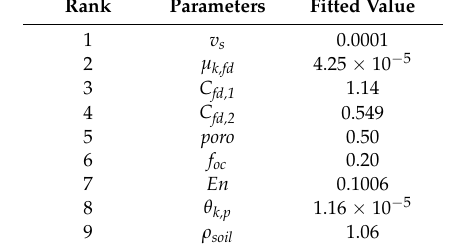
Table 7. Sensitive parameters of the modified pesticide